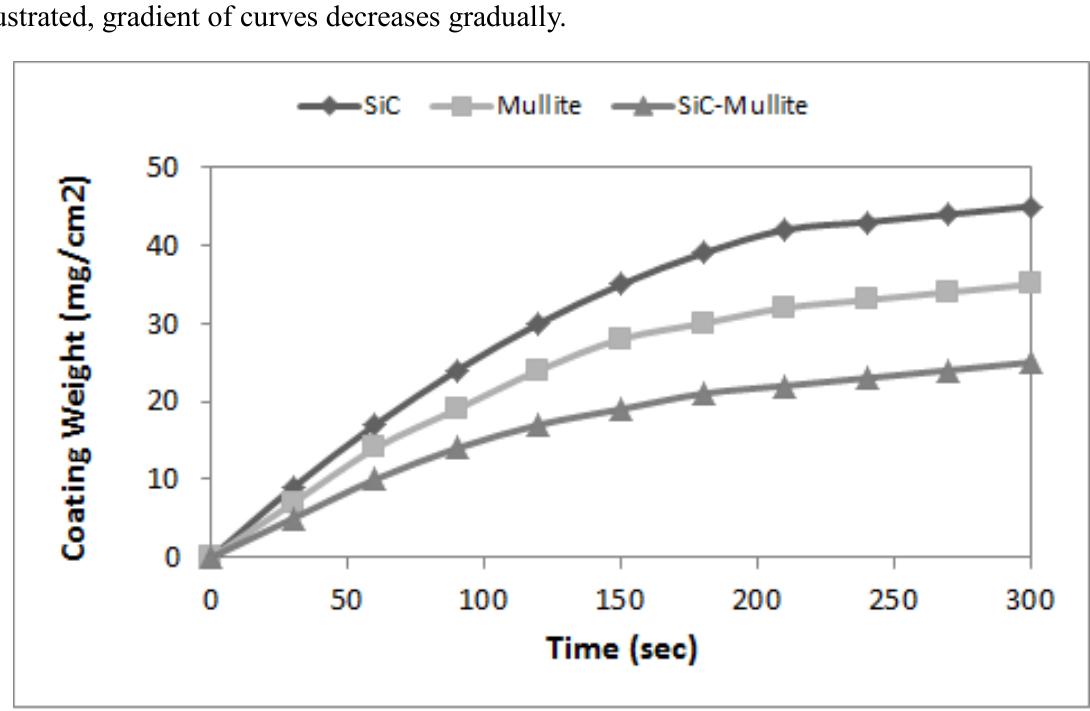
Fig. 1. Weight vs. time of coating for various